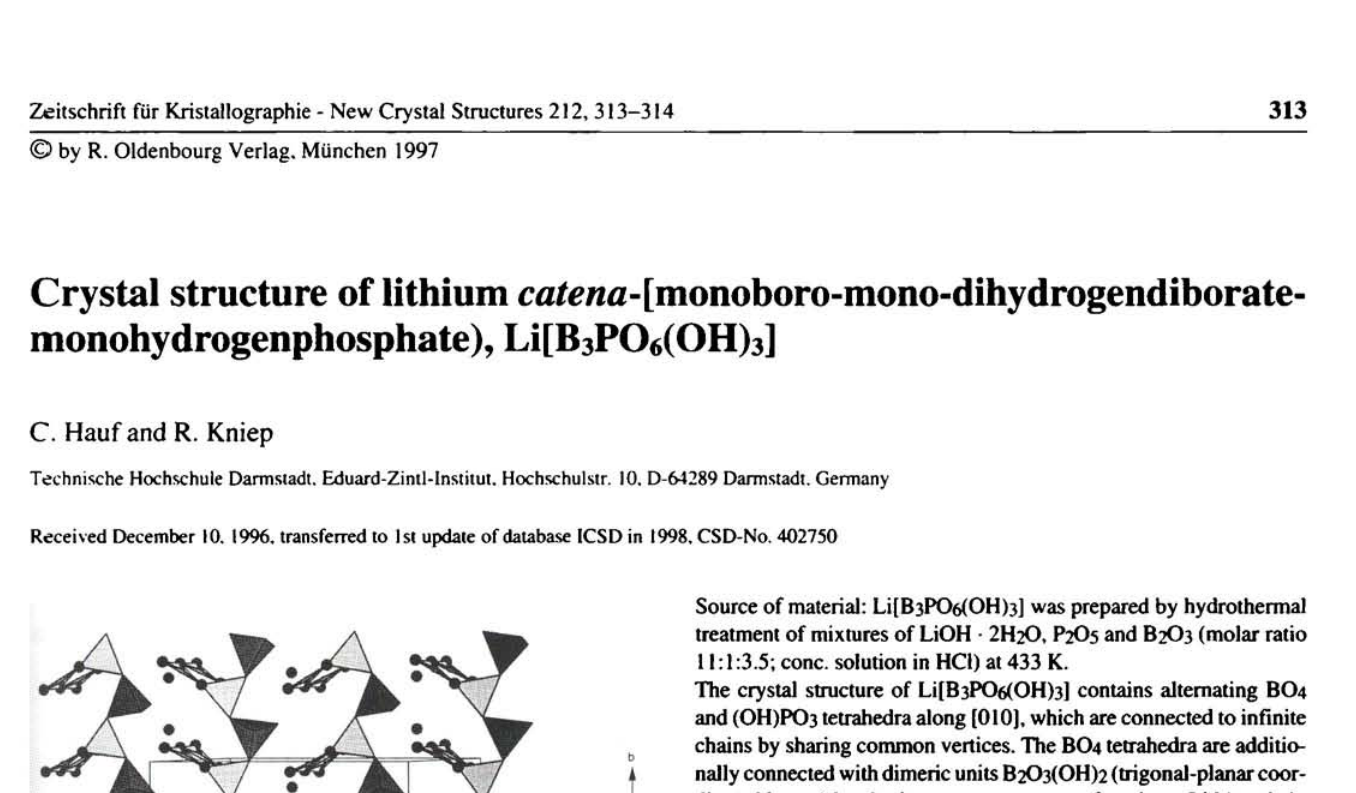
Fig. 1. Infinite anionic chains in the crystal structure of Li [B3POe (OH )3] tunning along [010]: dark: (OH)PC >3 tetrahedron; light BO4 tetrahedron; ball and stick: trigonal planar B20j(0H)2 -units; isolated spheres: Li*.